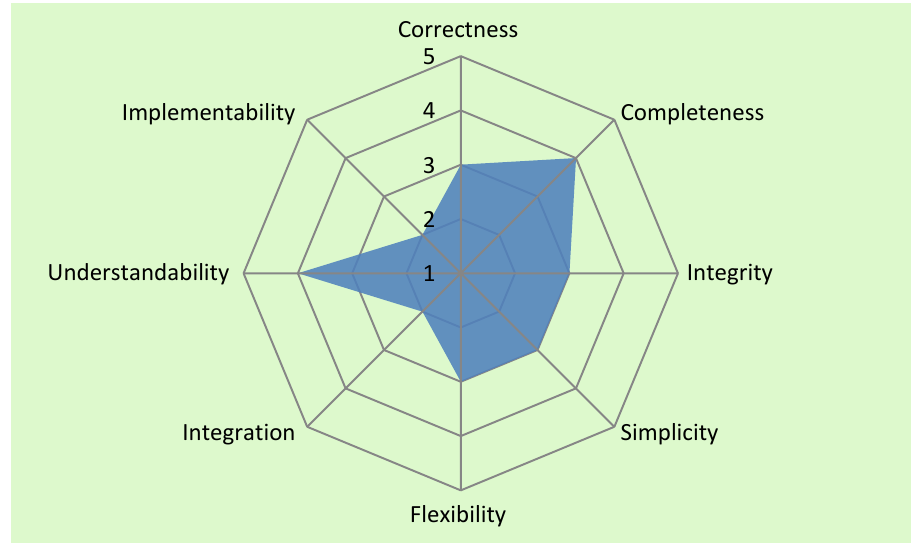
Figure 25. Subjective ratings of the 3DCDM model